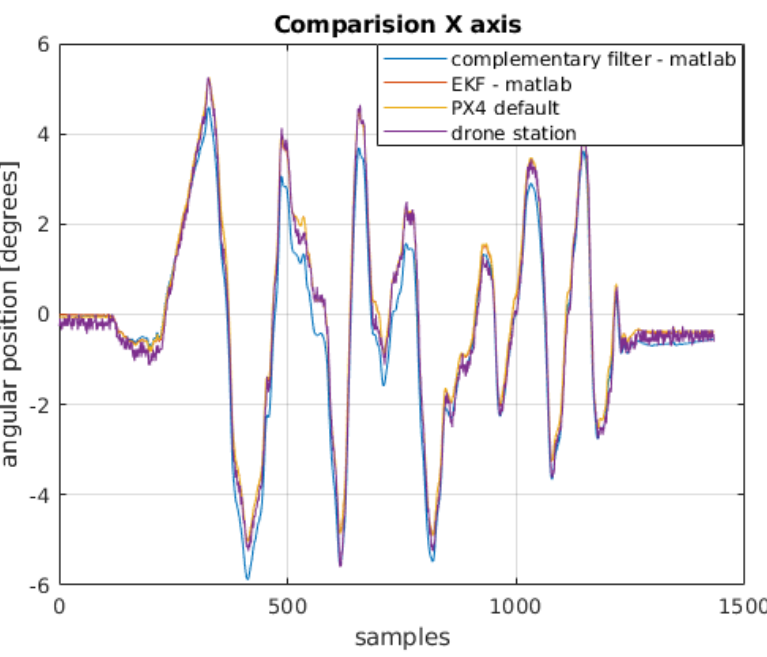
Figure 13. Comparison of the angular position obtained from the filters with the physical position for the X-axis.